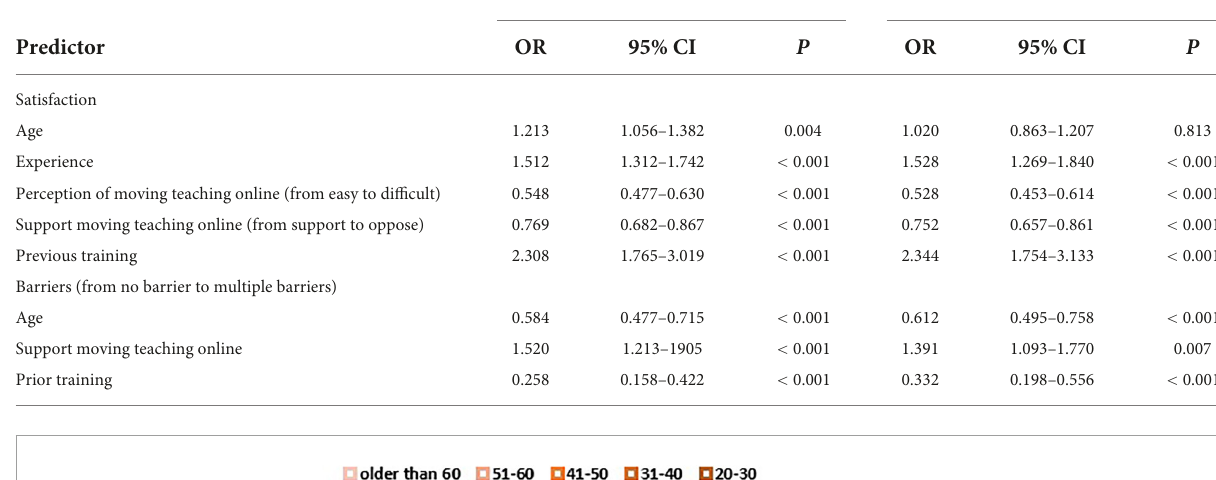
TABLE 5 Multivariable logistic regression analysis of predictors for satisfaction and barriers.